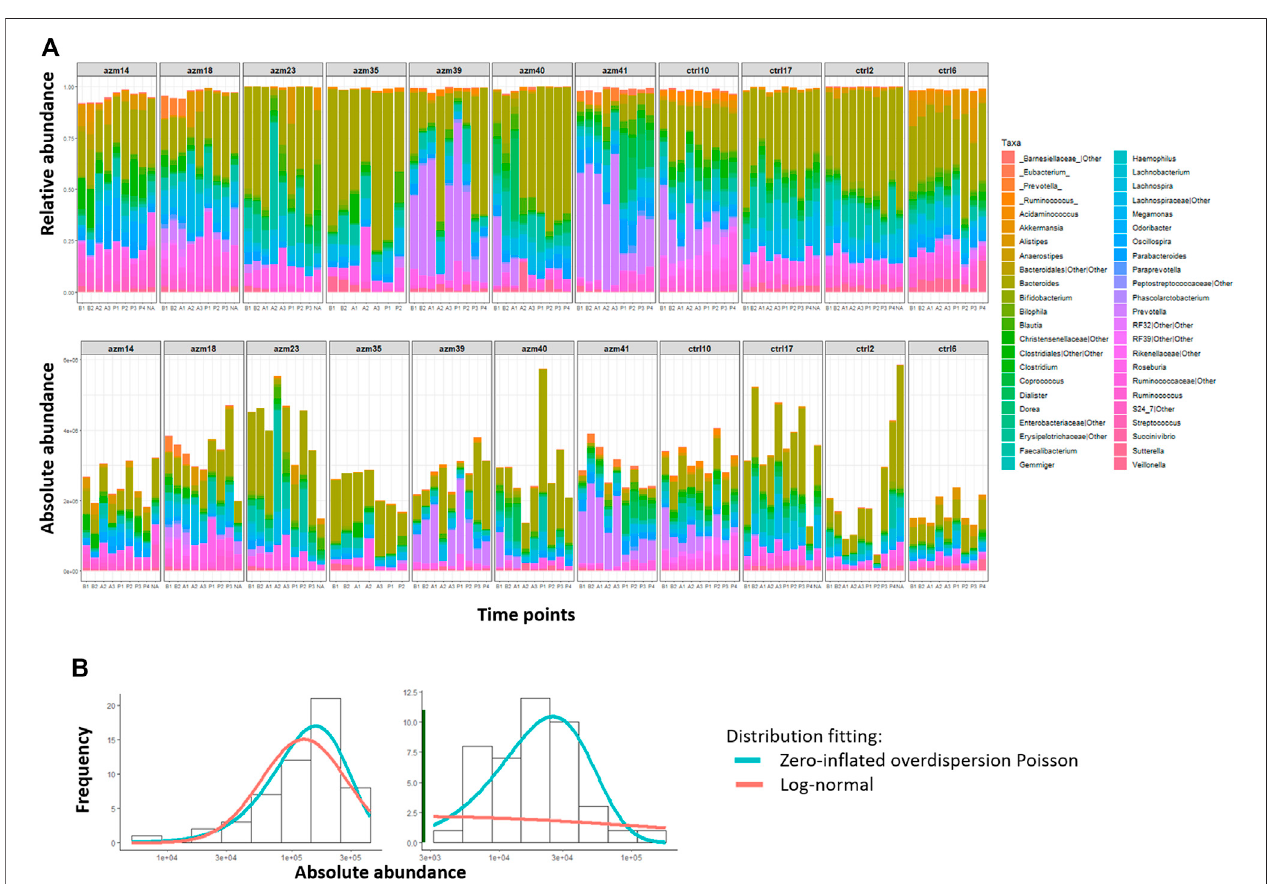
FIGURE 4 | MIME study microbiome data. (A) Difference between relative abundances (top panel) and absolute abundances based on qPCR (bottom panel) of dominant genera in XX fecal samples obtained from 21 subjects (block) at 7 – 9 time points ( x -axis) each. (B) Distribution of absolute abundances of two representative generafromtheMIMEstudy,shownintheleftandrightpanels,respectively.Foreachgenus,theabsoluteabundanceis fi ttedwithalog-normaldistribution(redline)ora two-part distribution: a zero part (dark green line shown in right panel) and a non-zero part fi tted with an over-dispersion Poisson distribution (blue line).